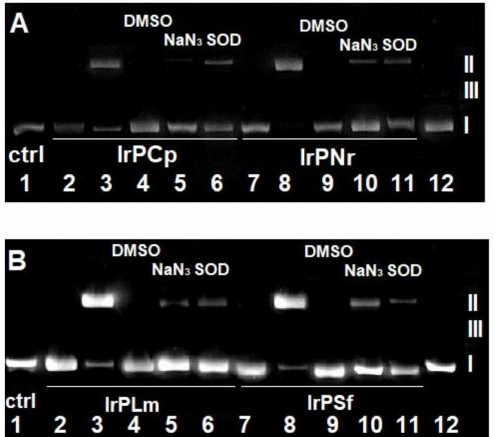
Figure 5. Agarose gel electrophoresis of pBR322 plasmid cleavage by: ( A ) IrPCp and IrPNr .